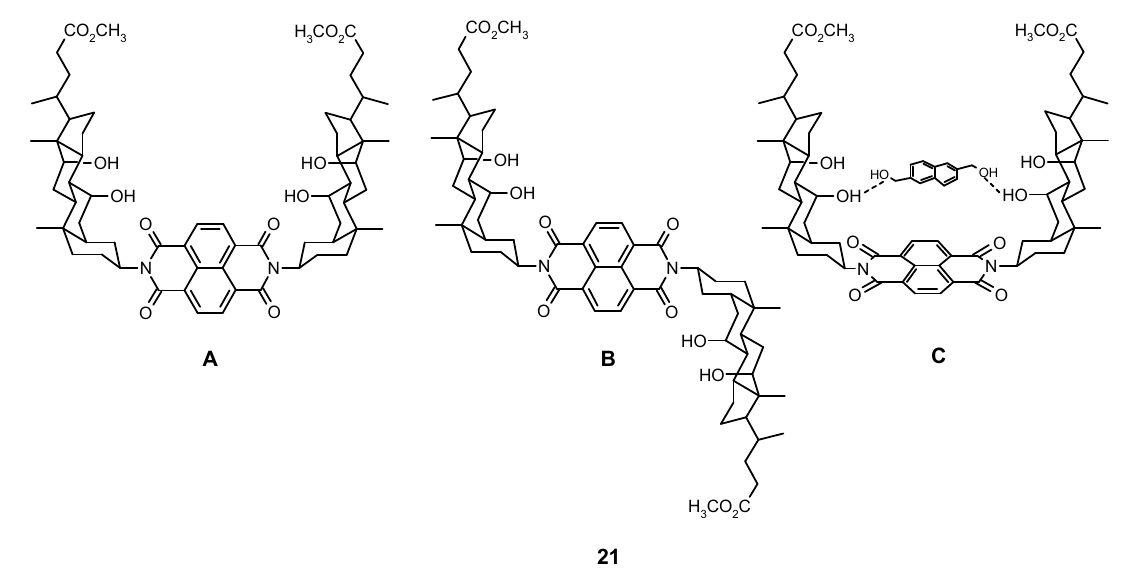
Figure 11. Two stable conformations A and B of the free host molecule 21 and the cleft-type conformation C induced by the inclusion of the 2,6-bis(hydroxymethyl)naphthalene [95].